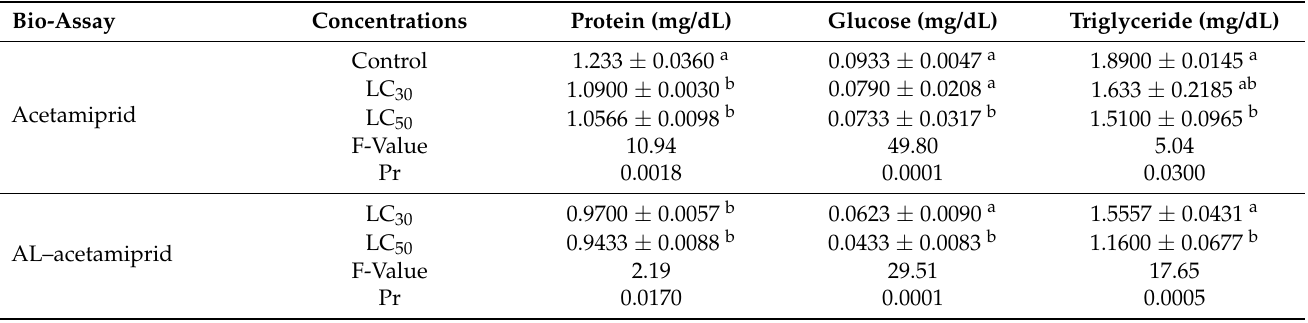
Table 2. Effect of free and nanoencapsulated acetamiprid based on AL and PEG on macromolecules in third-instar larvae of Xanthogaleruca luteola